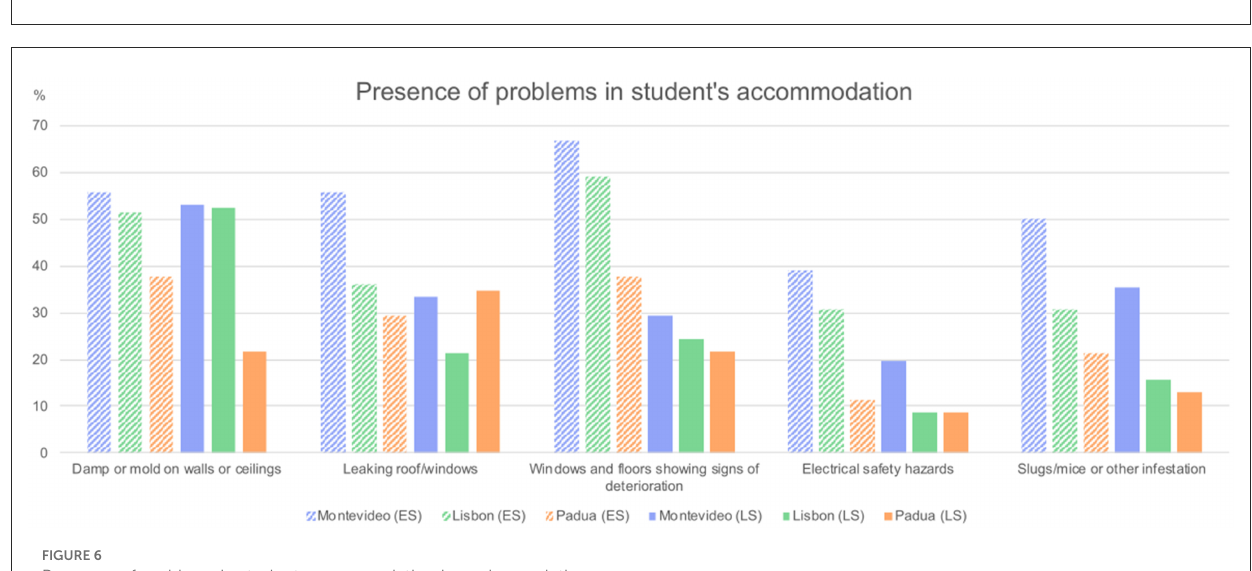
FIGURE5 Energy costs challenges for each population during summer.